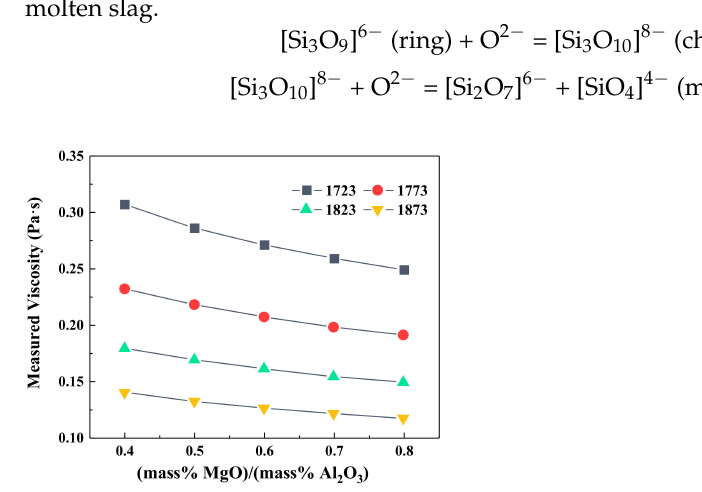
Figure 6. The viscosity of BF slag with different MgO/Al 2 O 3